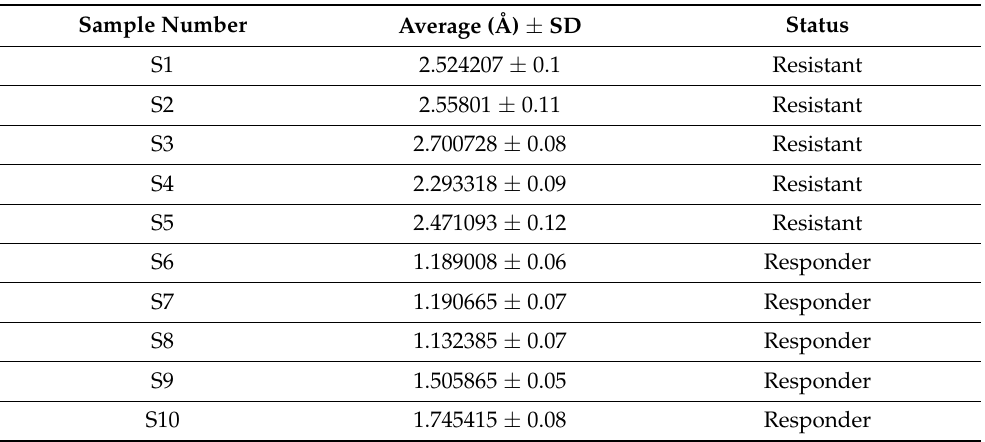
Figure 8. The RMSD of five dynamic simulation experiments for HCV 4a NS5B resistant samples. The blue color represents sample 1, brown represents sample 2, black represents sample 3, yellow represents sample 4, and red represents sample 5. Table 7. Average RMSD for 10 molecular dynamic samples for 50 ns (five resistant and five responder